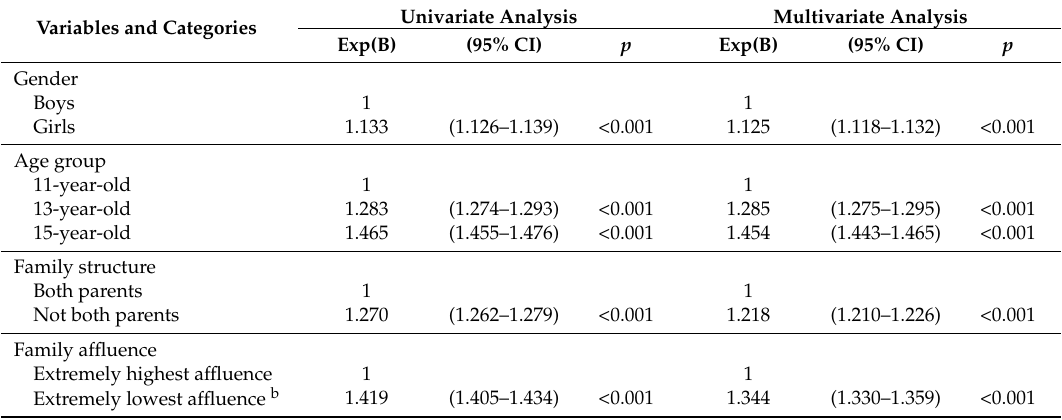
Table 1. Gender, age, family structure and family affluence impacts on adolescent life satisfaction a